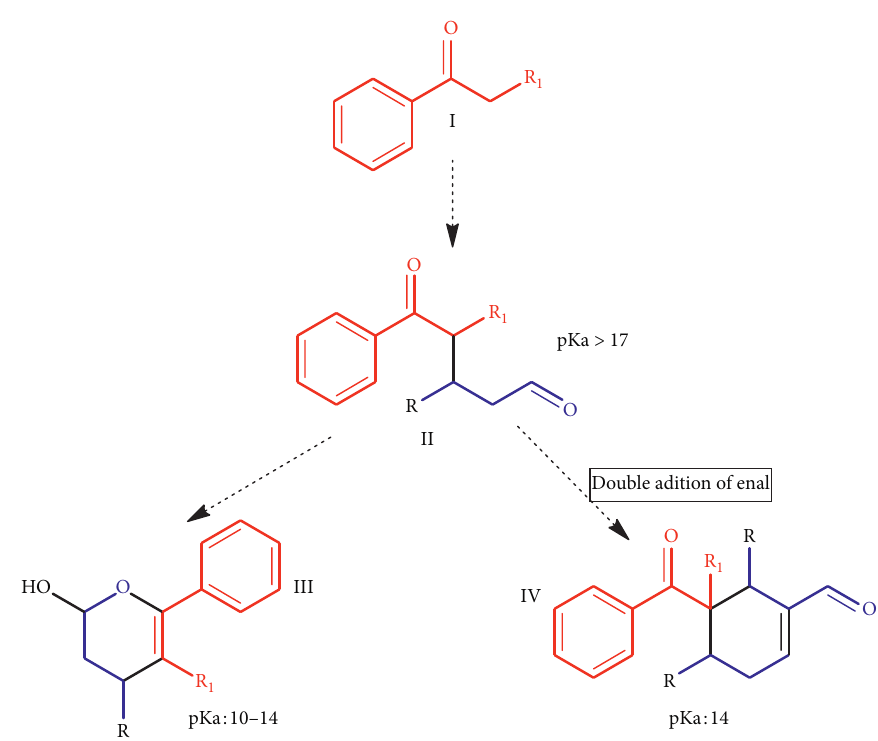
Figure 1: Possible structures that can be obtained by the Michael donor pKa